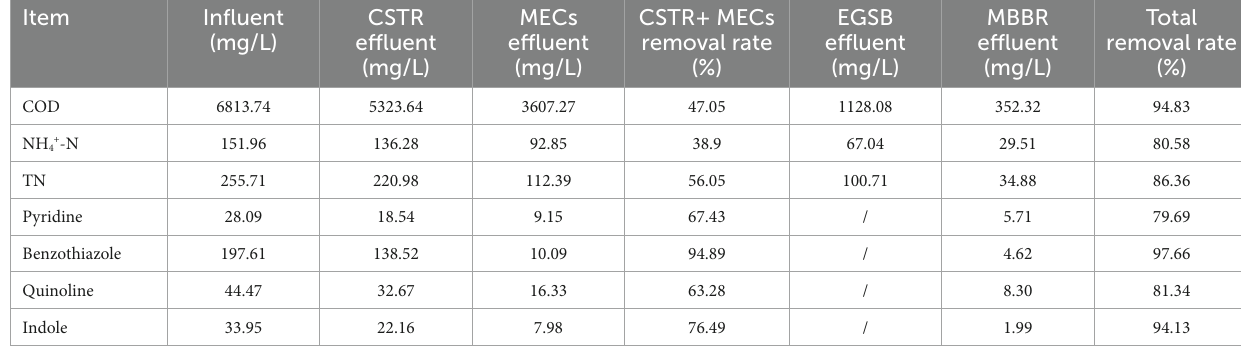
TABLE 2 The material balance of each pollutant (COD, NH 4+ -N, TN, and persistent pollutants) in the pharmaceutical wastewater treatment flow.